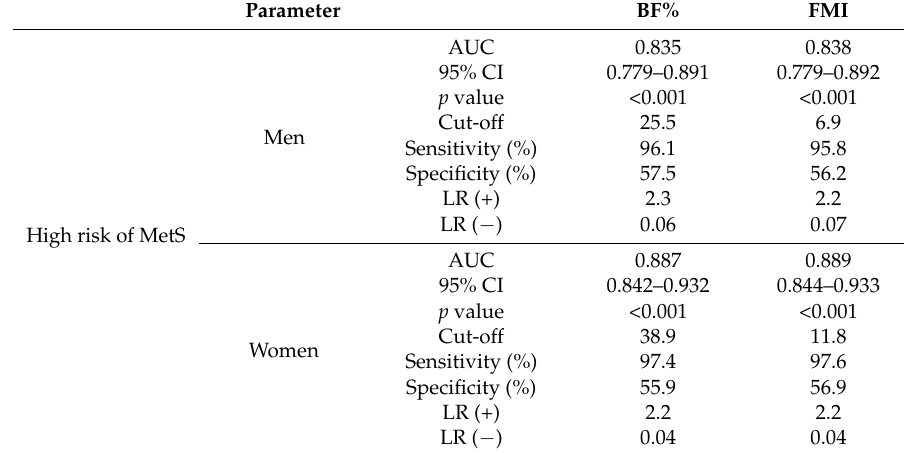
Table 4. Parameters of the ROC curves analysis for the diagnostic performance of body fat percentage (BF%) and fat mass index (kg/m 2 ) in identifying high risk of MetS according to the IDF criteria in men and